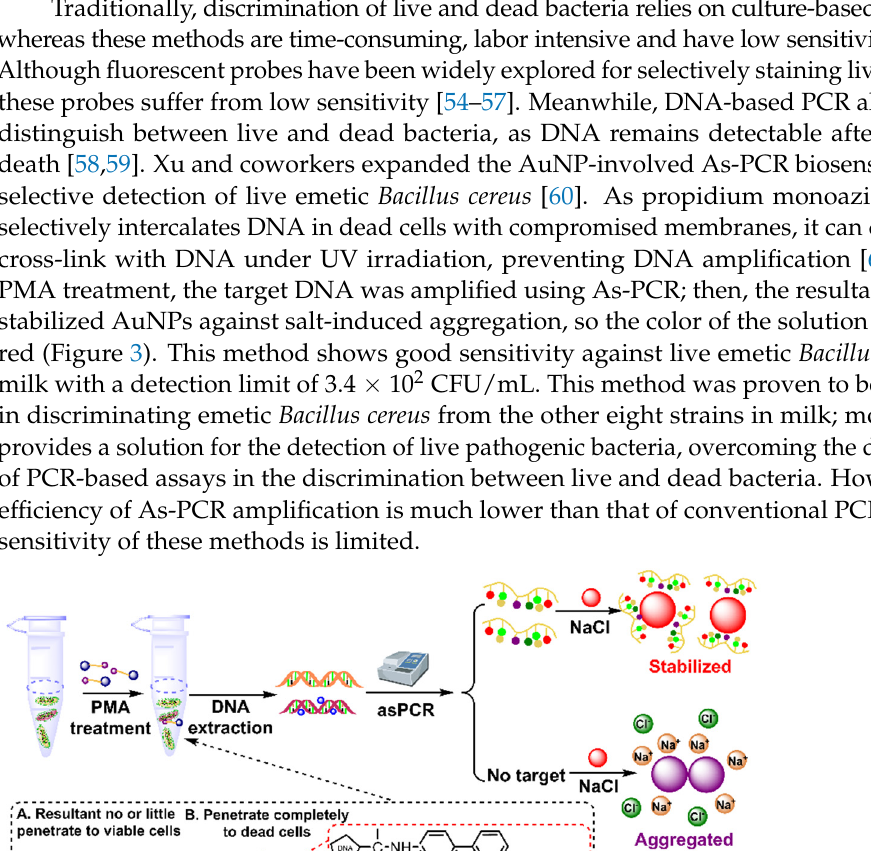
Table 1. Comparison of non-specific combinations of AuNPs with conventional PCR product. Detection Method